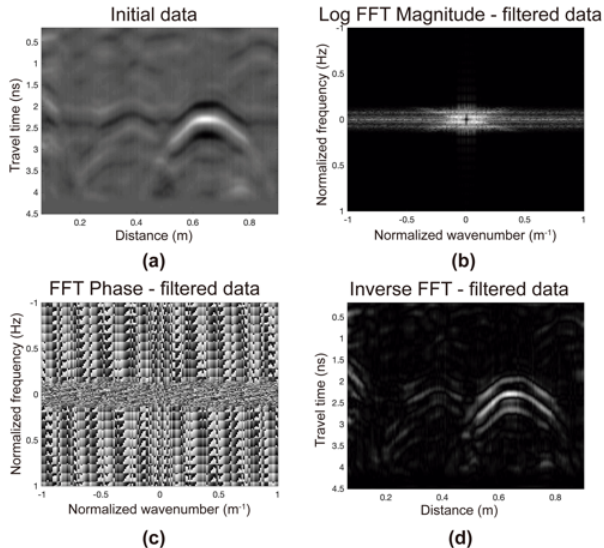
Figure 5. Results from the spectral filtering approach. ( a ) Input data in the space-time domain. ( b ) Magnitude spectrum of the filtered data. ( c ) Phase spectrum of the filtered data. ( d ) Filtered data in the space-time domain. The applied filter was effective to erase the CRN. However, this is